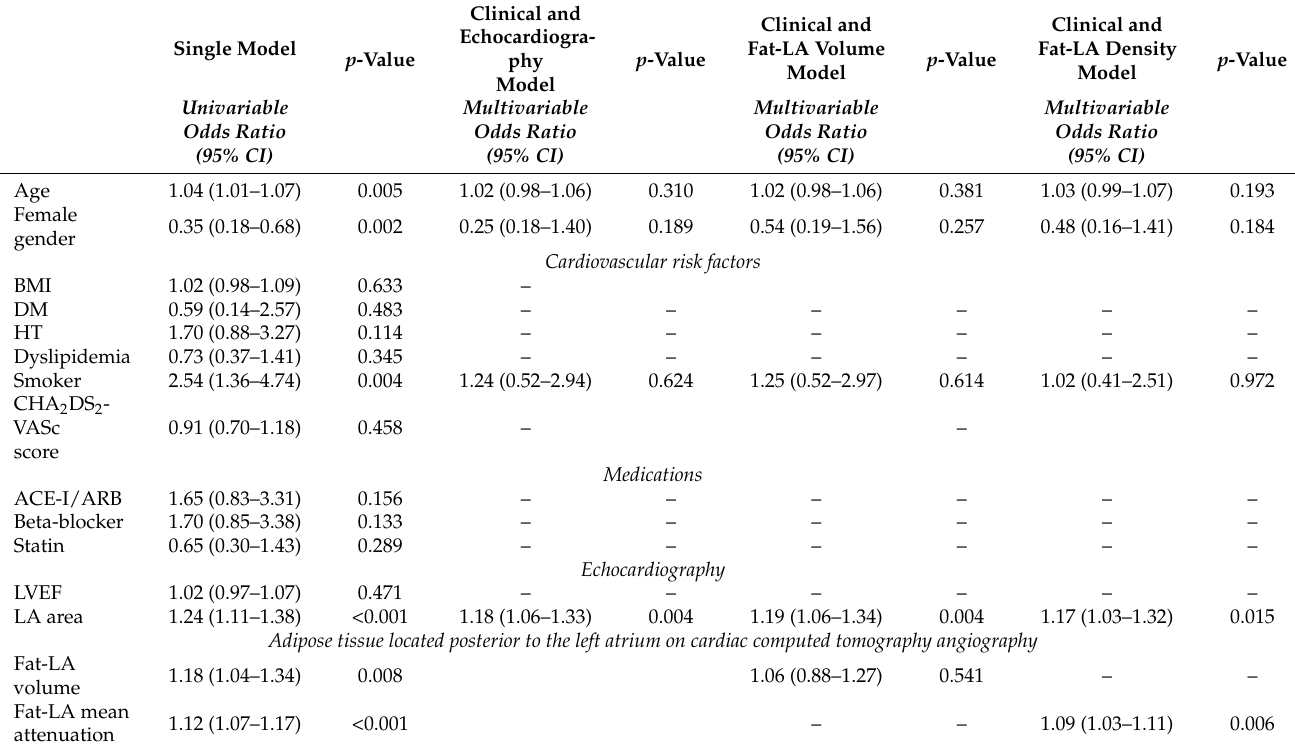
Table 2. Single and multiple variable logistic regression